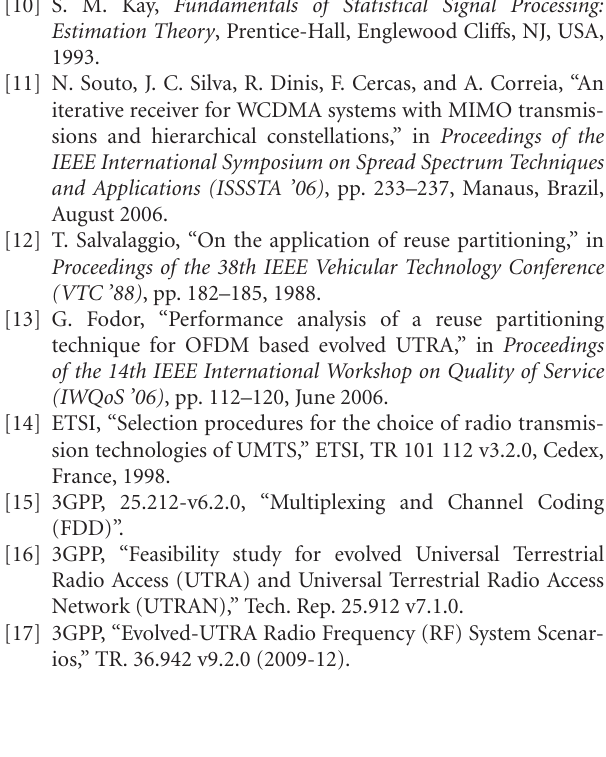
rate within the MBSFN network where coordinated MIMO transmissions